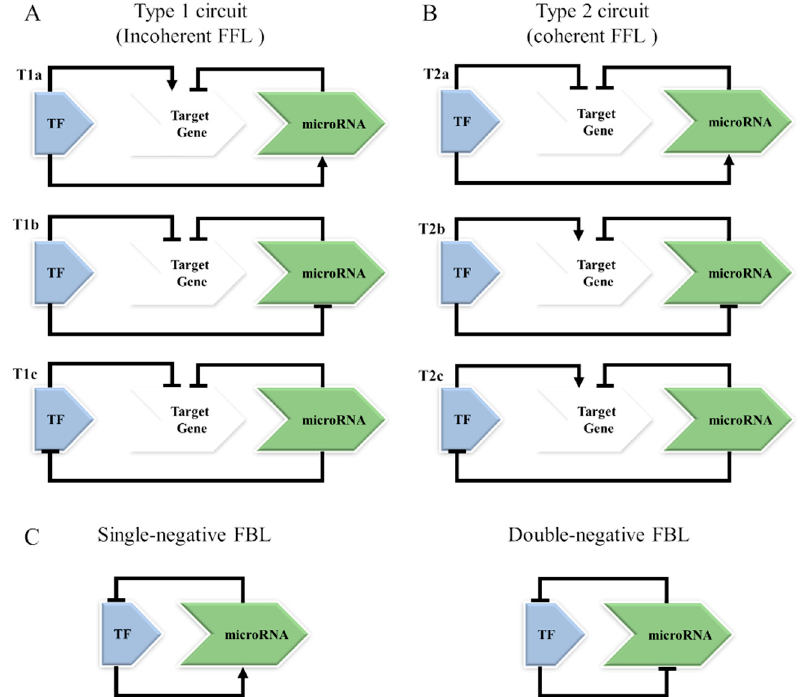
Figure 4 Schematic representation of different networks involving transcriptional factors and Figure 4. Schematic representation of di ff erent networks involving transcriptional factors and miRNAs. ( A ) In type 1 circuits, also known as incoherent feed-forward loops, the TF and miRNA together co-regulate a target gene, but the TF can regulate the miRNA expression or vice versa. The TF can induce miRNA expression (T1a) or repress (T1b) or be repressed by the miRNA (T1c). ( B ) In type 2 circuits, also known as coherent feed-forward loops, the TF and miRNA have the same effects on the target gene, potentially activating or repressing its expression. The TF can repress the target gene and increase the expression of the corresponding miRNA repressor (T2a); the TF induces the target gene and represses its miRNA repressor (T2b); the miRNA that represses a target gene also